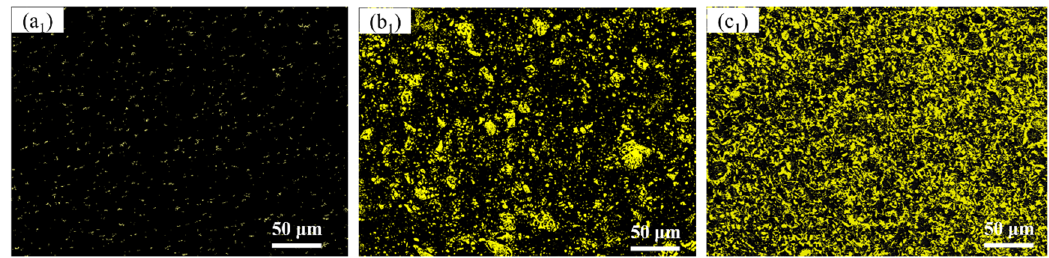
Figure 3. Image after region calibration. ( a1 ) Al 7075; ( b1 ) 15 wt.% VN/7075; ( c1 ) 20 wt.% TiB 2 -TiC x /7075.